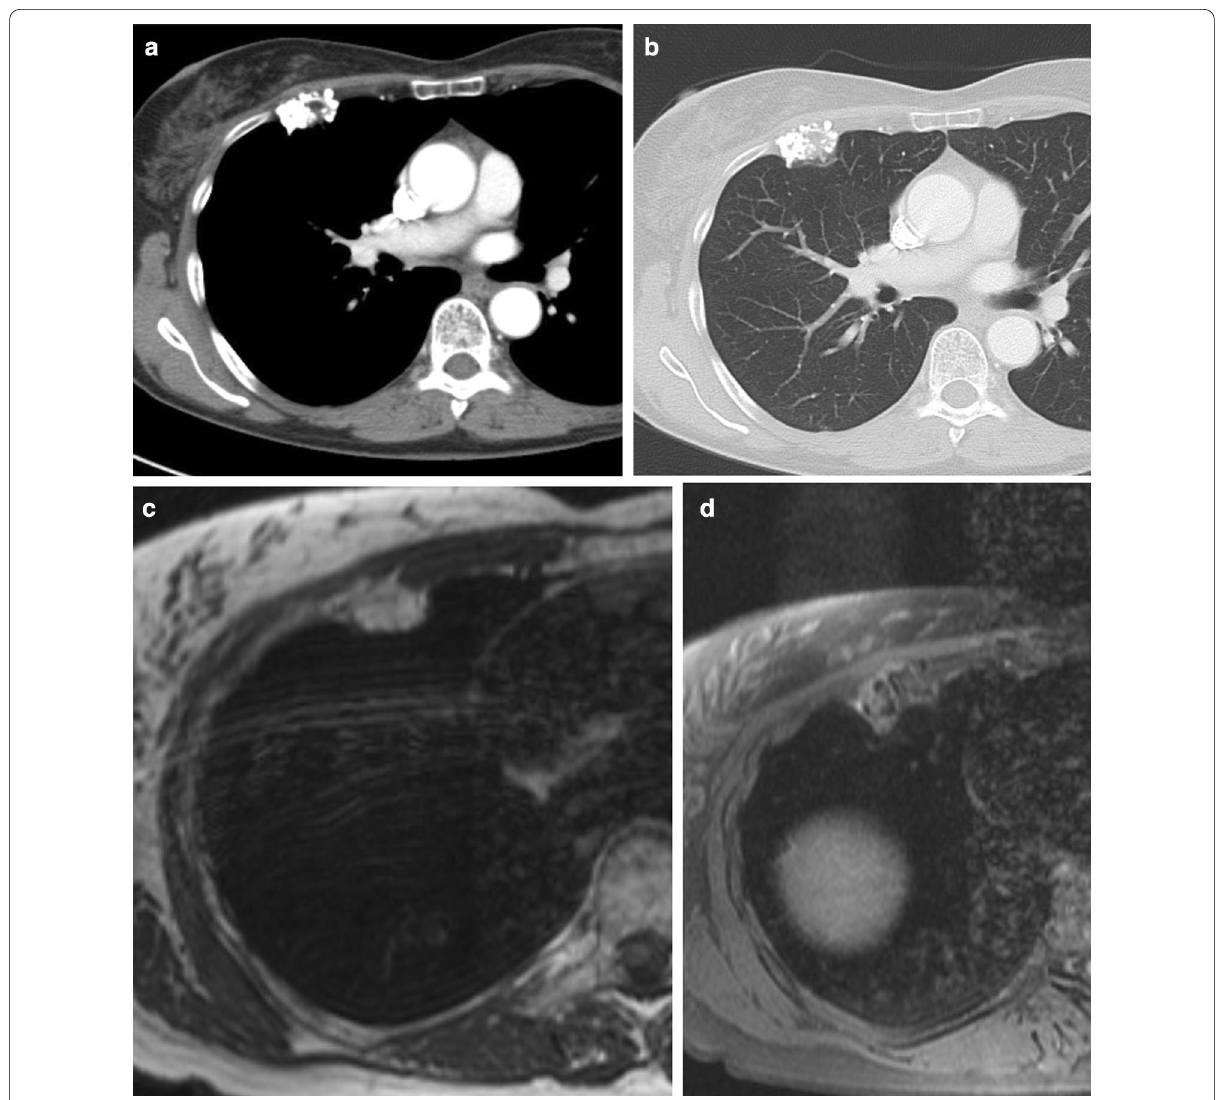
Fig. 9 Diagnosis: chondrosarcoma. Technique: contrast-enhanced chest CT and MRI. Description: A 64-year-old woman with a history of smoking, presented due to shortness of breath. The axial contrast-enhanced CT scan ( a , b ) reveals an expansile lesion with extensive calcifications located at the costochondral junction of the right 3rd rib (note a typical arc-and-ring pattern of calcification). On the axial T1-weighted MR image ( c ) the lesions have a high signal intensity. The axial T2-weighted MR image ( d ) shows a peripheral hyperintense mass with internal low-intensity foci, reflecting the cartilaginous matrix with chondroid